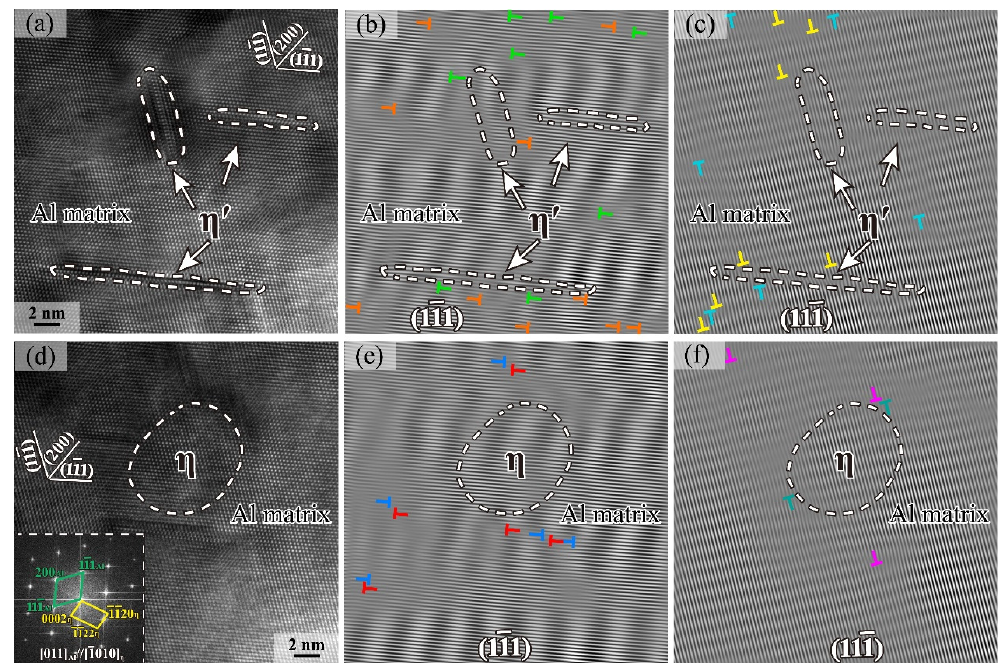
Figure 12. ( a ) HRTEM image of η′ precipitate in sample II (100 °C), ( b , c ) corresponding inverse FFT patterns of ( a ), ( d ) HRTEM image of η precipitate in sample II (100 °C), ( e , f ) corresponding inverse FFT patterns of ( d ). Dislocations with different Burgers vectors are labeled by different colored ‘T’ symbols.